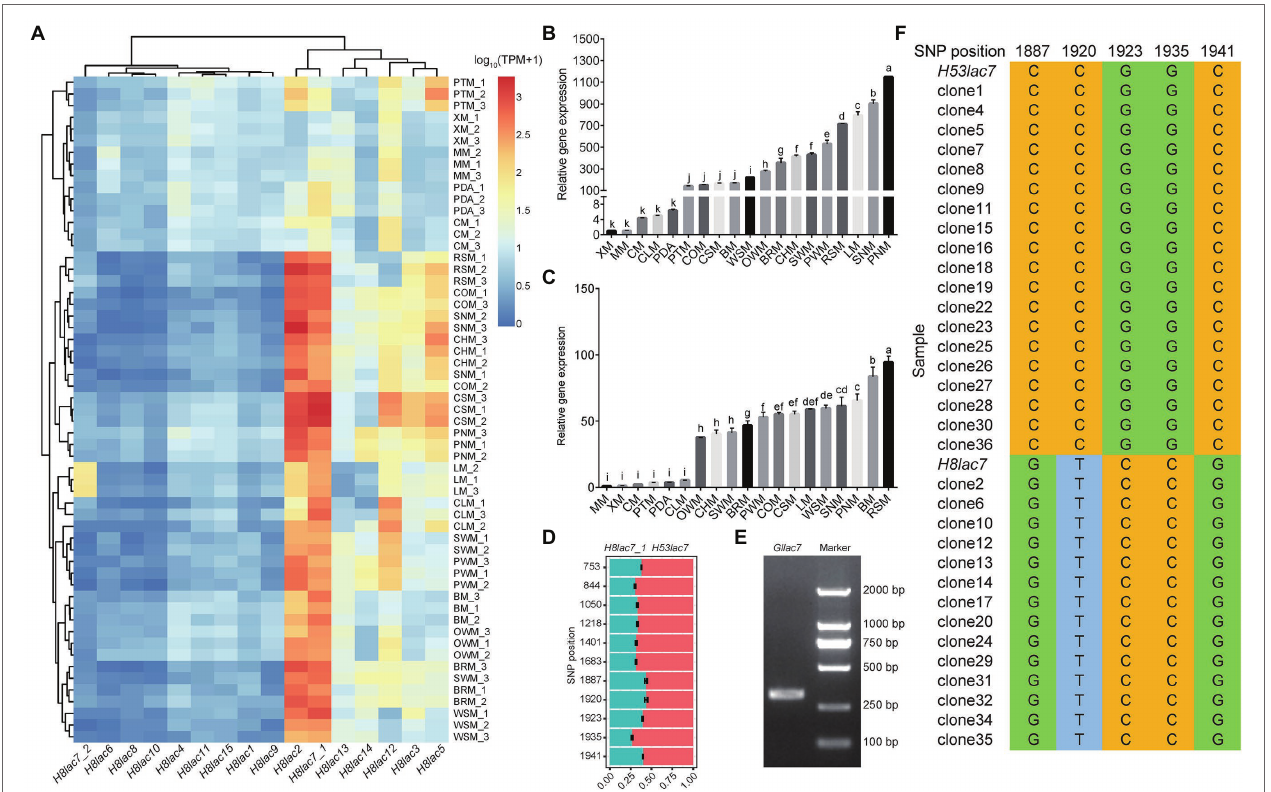
FIGURE 3 | Expression patterns of laccase genes in G. lucidum . (A) Expression levels of 16 laccase genes on different carbon sources. (B) Relative expression of Gllac2 detected by qPCR. (C) Relative expression of Gllac7 detected by qPCR. (D) Read count of allelic Gllac7 based on SNP loci in the mycelia cultured on RSM. (E) Agarose gel electrophoresis of PCR amplification products of partial Gllac7 (311 bp). (F) SNP loci validation by clone sequencing. Glucose (MM), lignin (LM), cellulose (CM), xylan (XM), corncob (COM), cottonseed hull (CHM), wheat-straw (WSM), rice-straw (RSM), bran (BRM), pine wood sawdust (PWM), pine needle (PNM), spruce wood sawdust (SWM), spruce needle (SNM), pteridophyte (PTM), chestnut shell (CSM), chestnut leaf (CLM), bagasse (BM), oak wood sawdust (OWM), and potato dextrose agar (PDA). The error bars with different letters over the columns denote significant differences ( p <